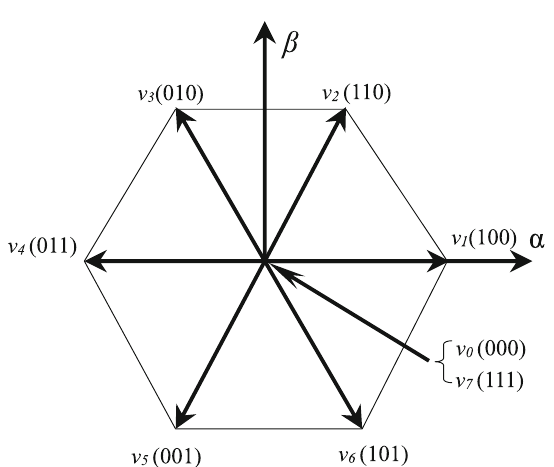
Fig. 2 Voltage vectors delivered by the two-level inverter